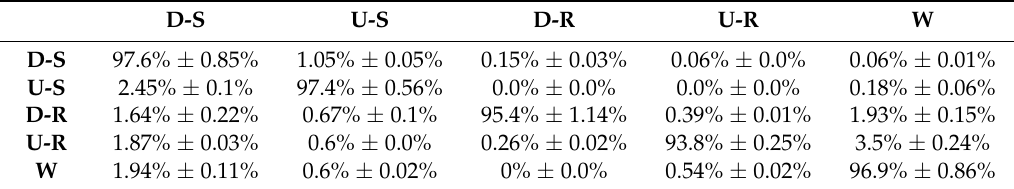
Table 3. Confusion matrix for experimental results of PSO-SVM.